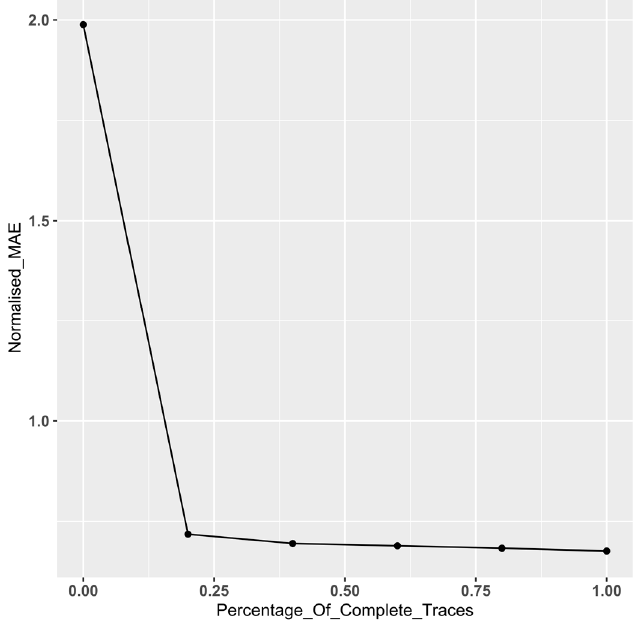
Figure 7. BPIC 12—Normalised MAE by proportion of incomplete traces.